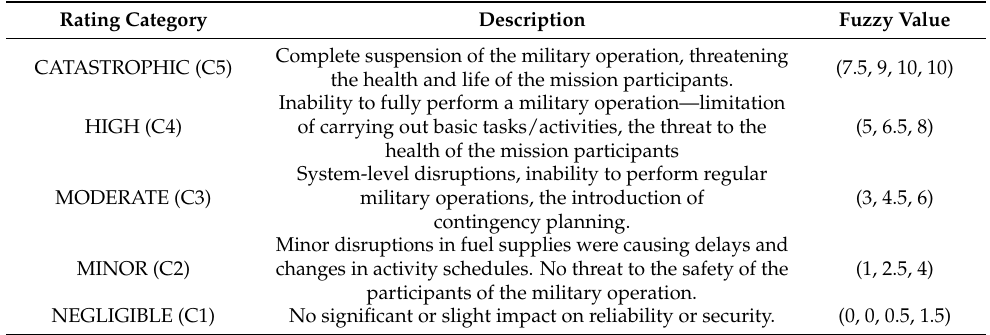
Table 4. Consequences of scenario occurrence.